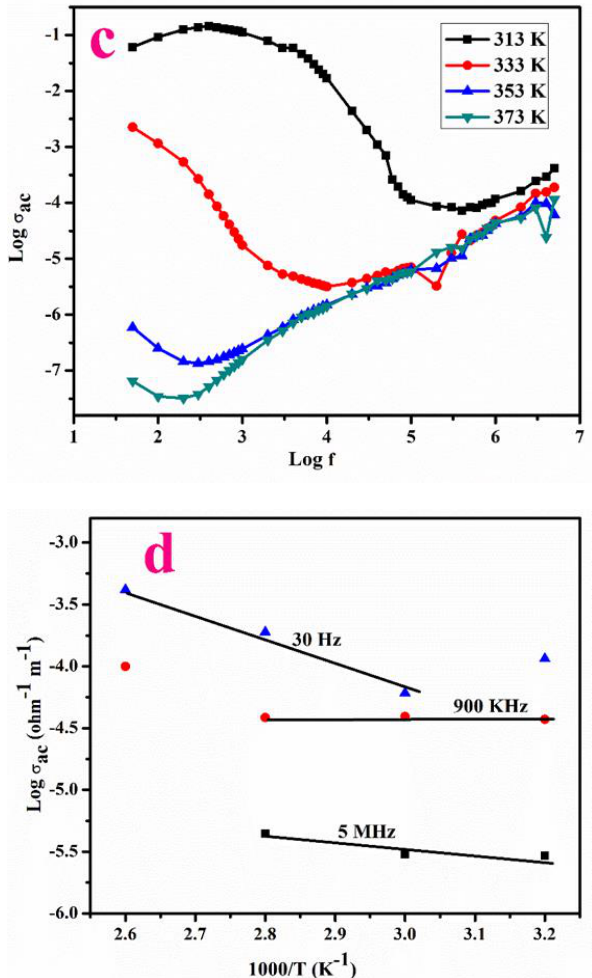
Figure 7. Variation of ( a , b ) logarithm of frequency versus dielectric constant, dielectric loss, ( c , d ) Logarithm of ac conductivity versus log f.